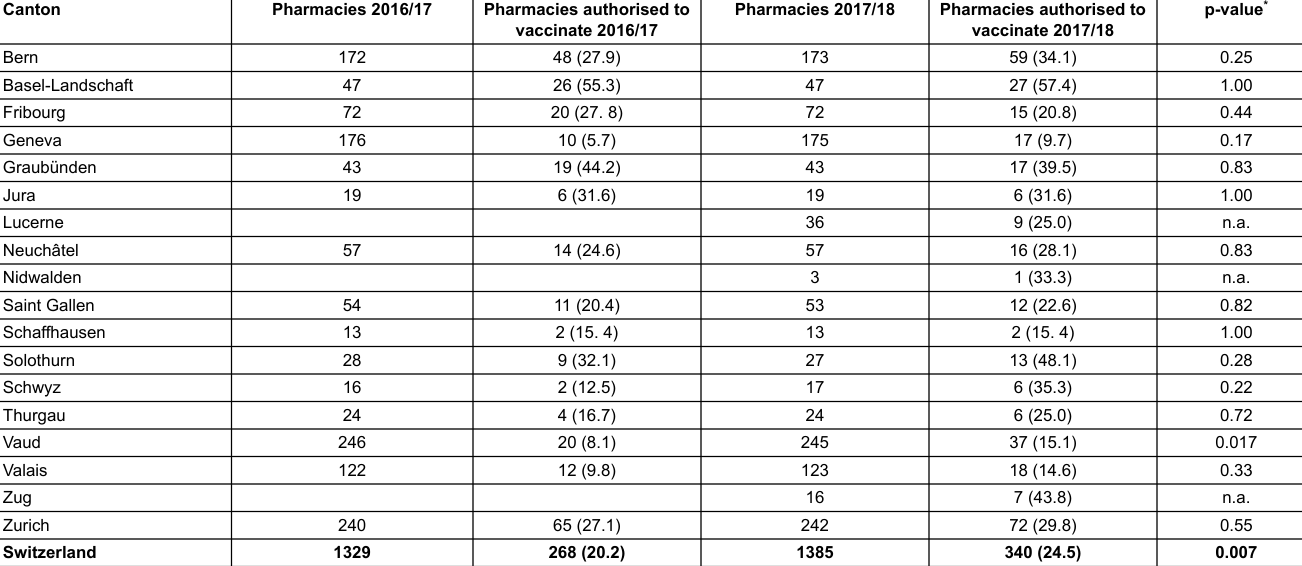
Table 3: Pharmacies authorised to vaccinate in Switzerland in the 2016/17 and 2017/18 influenza seasons.